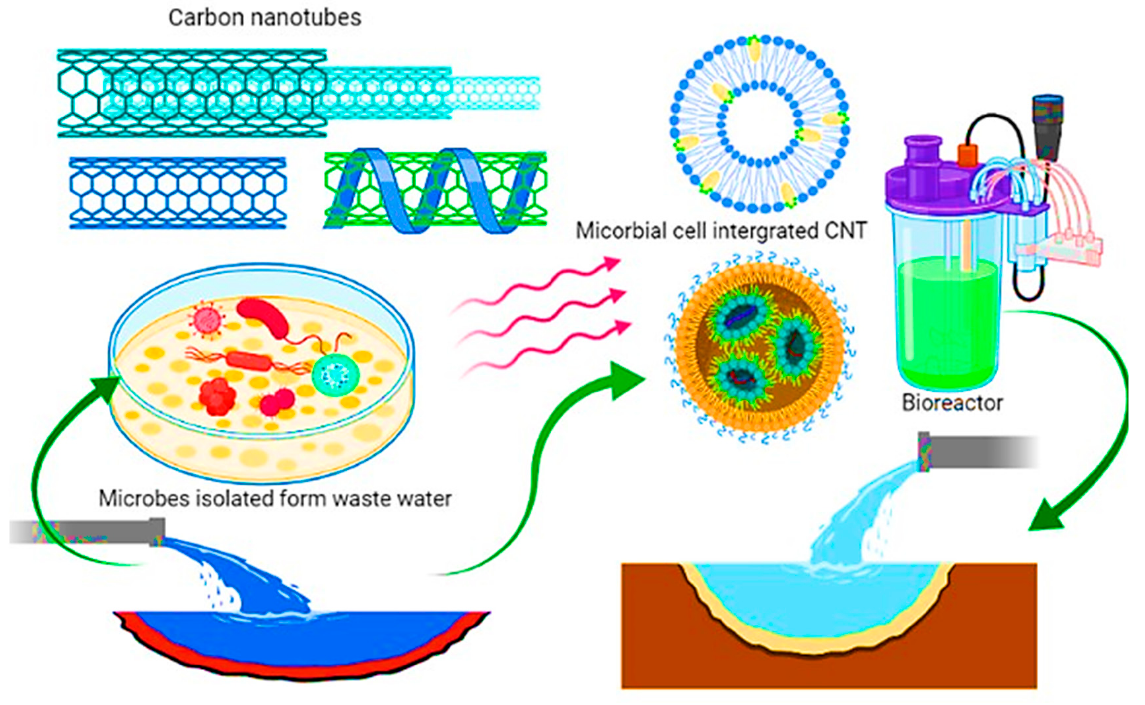
Figure 7. CNT-microbial integrated approach for waste water treatment and bioremediation of pollutants.